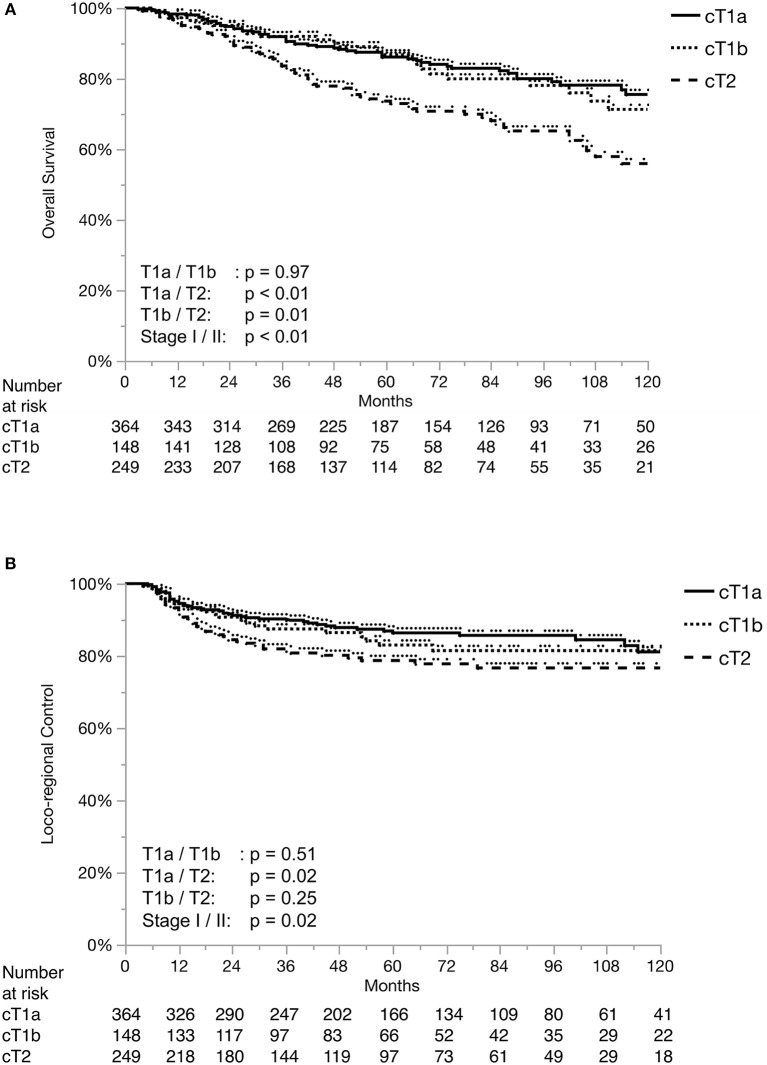
Overall Survival (A) and Loco-regional control (B) separated by T stage.